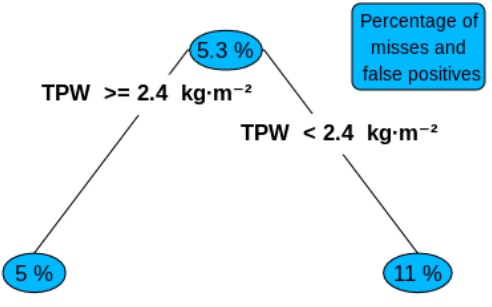
Figure 4. Decision tree, with the percentage of missed and false positive supercooled occurrence indicated in boxes, and partitioning variables and thresholds indicated on branches.